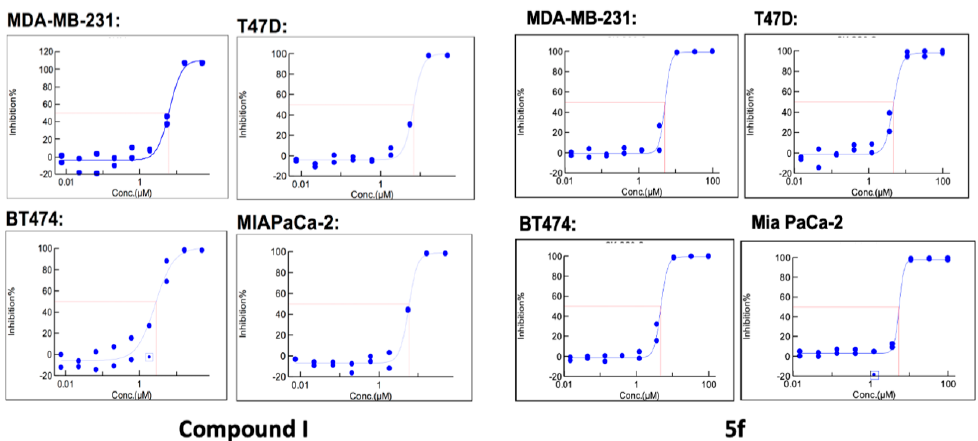
Figure 9. Antiproliferative activity of compounds I and 5f across three human breast cancer cell lines (MDA-MB-231, BT474, and T47D) and one pancreatic cancer (Mia PaCa-2) cell line.